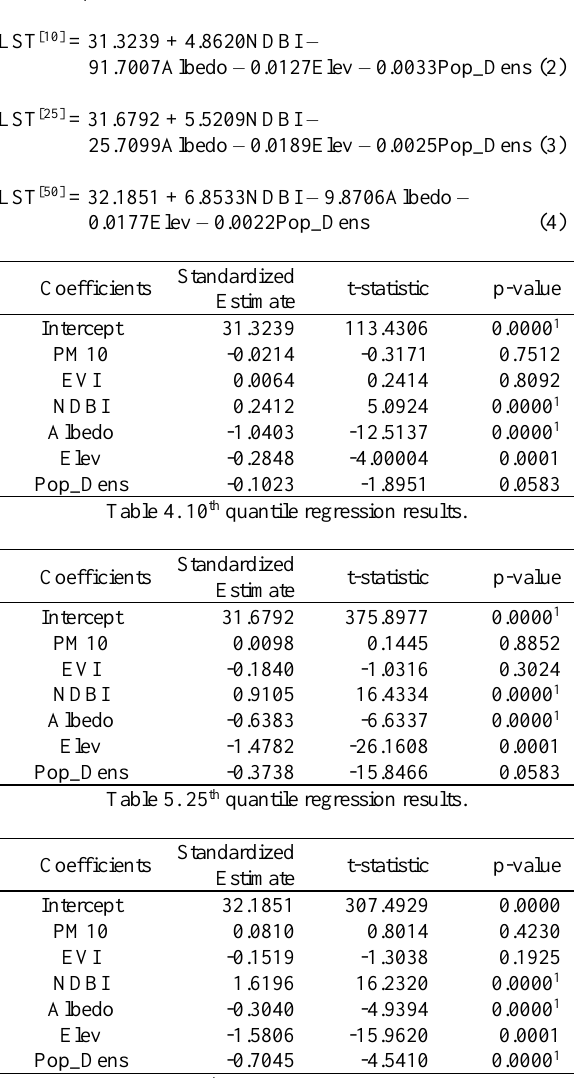
Table 6. 50 th quantile regression results.